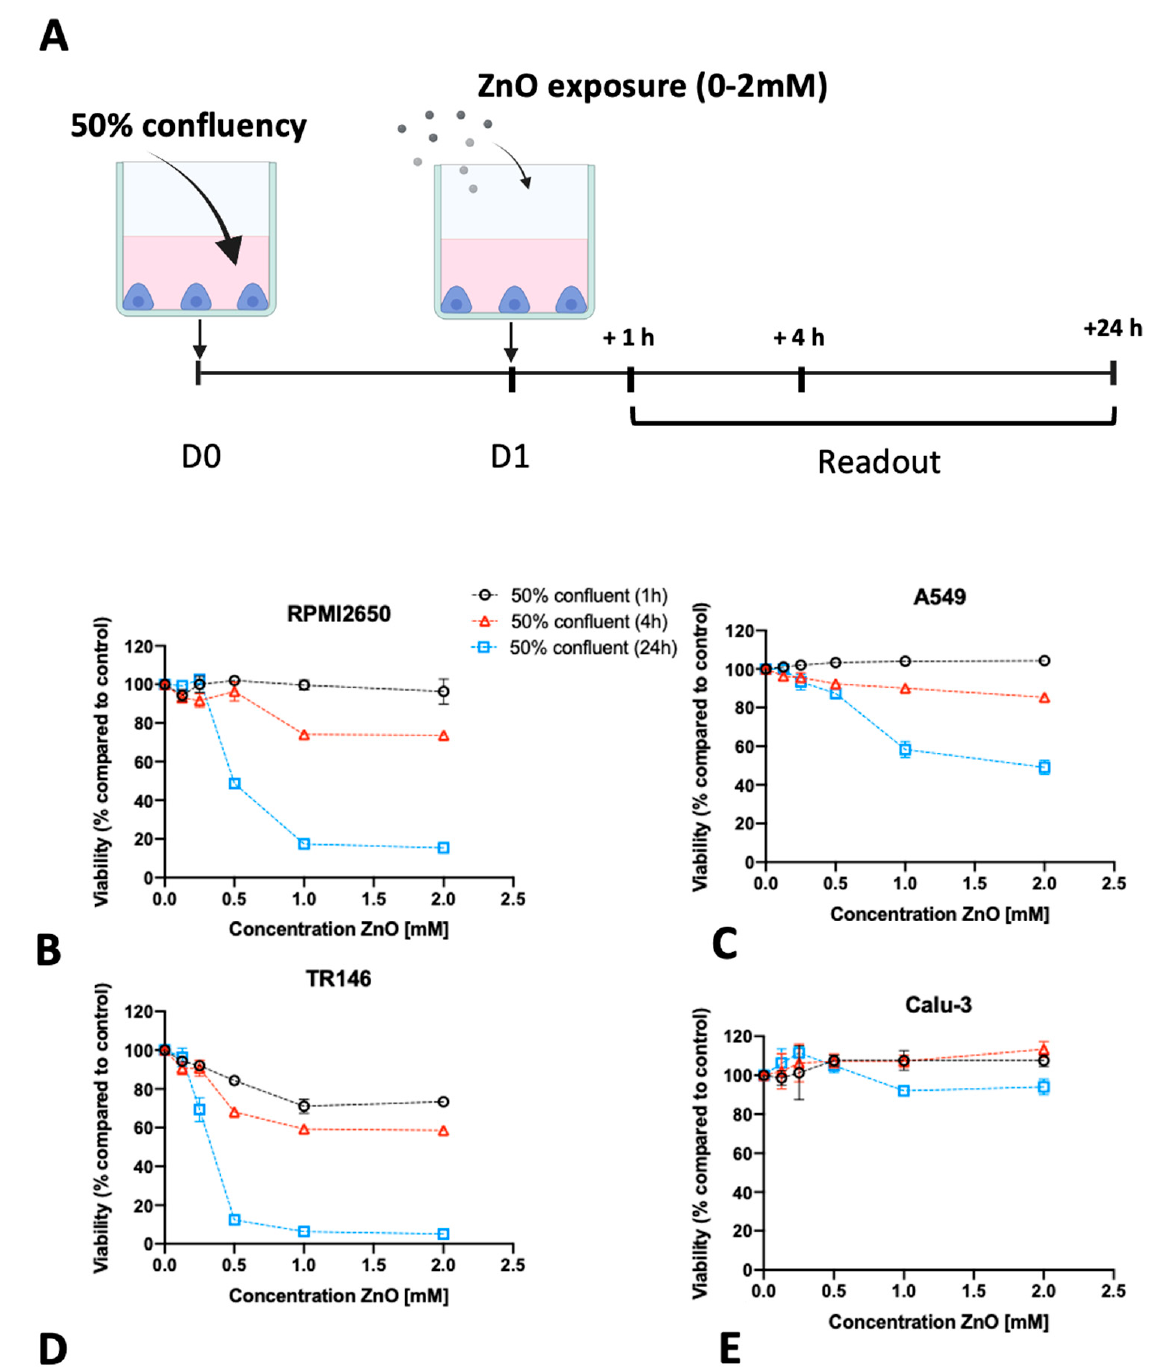
Figure 4. ( A ) Visual representation of the assay protocol for investigating the impact of 50% initial seeding density on nanotoxicological readout using Presto Blue viability assay. ( B – E ) ZnO nanoparticle toxicity of immature barrier cell monolayers in conventional cell culture-treated microtiter plates at 50% cell confluency, 24 h post-seeding, using a Presto Blue assay at 1, 4, and 24 h post-exposure to 70–90 nm sized, uncoated ZnO NPs in for ( B ) RPMI2650, ( C ) A549, ( D ) TR146, and ( E ) Calu-3. Data are expressed as mean ± standard deviation for n = 3 replicates.